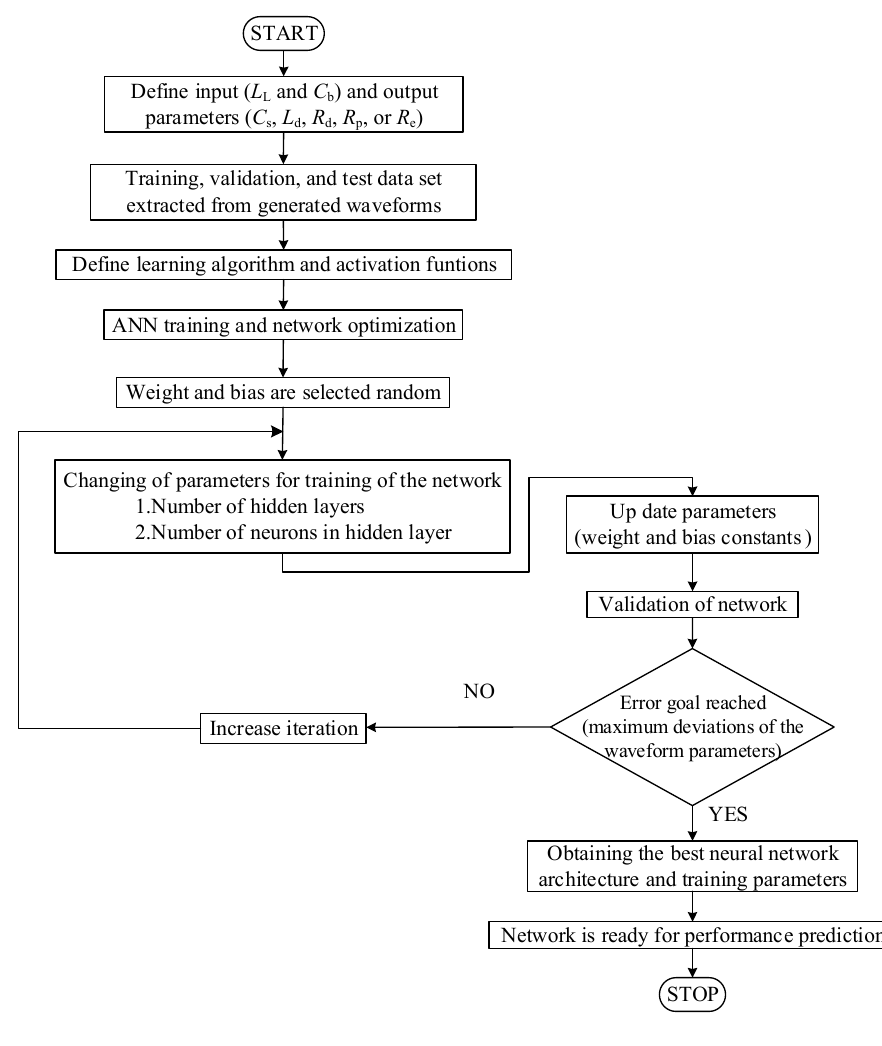
Figure 7. Flowchart of an ANN training.